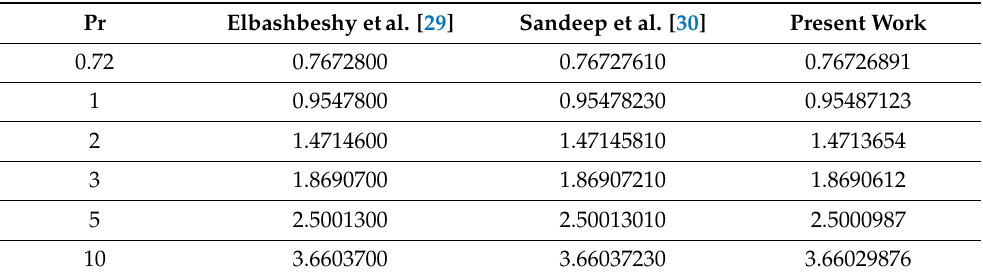
Table 3. Comparison of the present work with Elbashbeshy etal. [29] and Sandeep et al. [30] when the rest of the physical parameters are